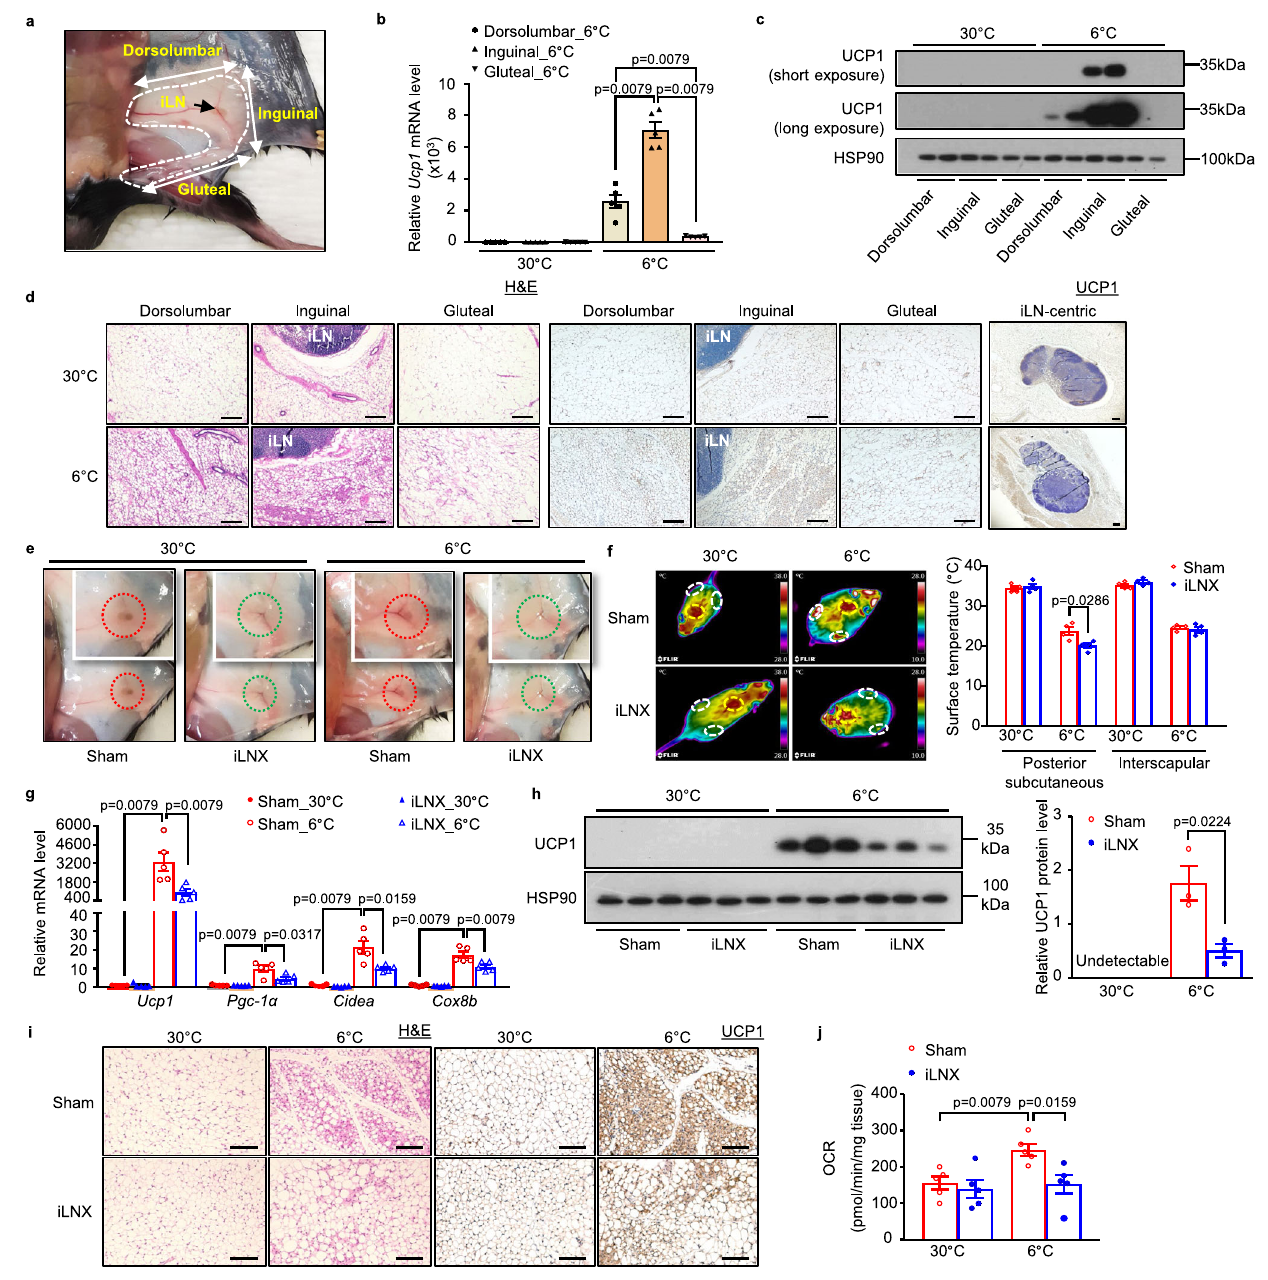
Fig. 1 | iLN promotes cold-induced beiging of scWAT. Eight-week-old male C57BL/6N mice were housed at thermoneutral environment (30°C) for 3 weeks and then subjected to exposure at 6°C or 30°C for 2 days. a In situ orientation of posteriorscWAT(whitedashedlines).iLN(blackarrow);dorsolumbar,inguinaland glutealregions(two-headedwhitearrows). b , c ThemRNA( b )( n =5)andprotein( c ) ( n =3)expressions of UCP1 indifferent regionsofscWAT. d Representative images of different regions of scWAT stained with H&E (left) and immunohistochemical (IHC) staining for UCP1 (right). Scale bar, 200 μ m. e – j Mice were subjected to bilateral inguinallymphadenectomy(iLNX)orsham operation, and then housedat different temperatures as described above. e Macroscopic appearance of scWAT with (red-dotted circle) or without embedded-iLN (green-dotted circle) in sham- operated and iLNX mice. f Representative infrared images of sham-operated and